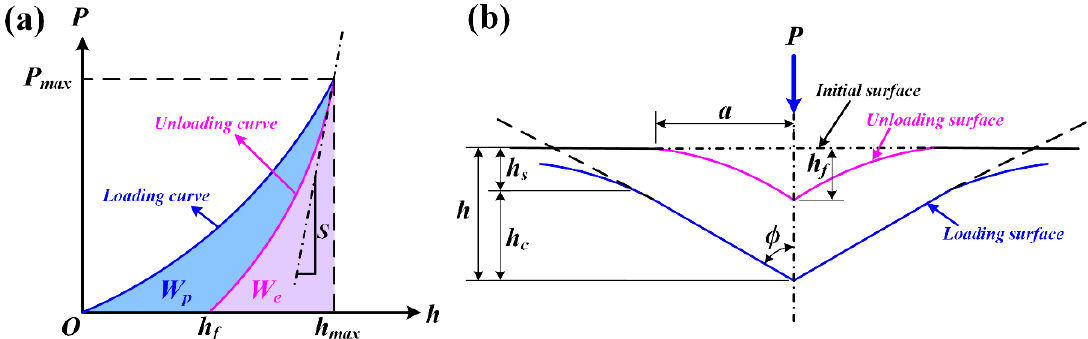
Figure 5. Schematic illustration of theoretical model of the Oliver–Pharr method: ( a ) displacement– force curve showing important measured parameters; ( b ) unloading process showing parameters characterizing the contact geometry.